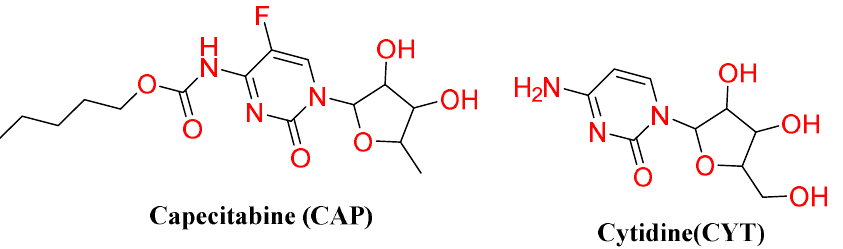
Figure 2. Chemical structures of CAP and CYT.